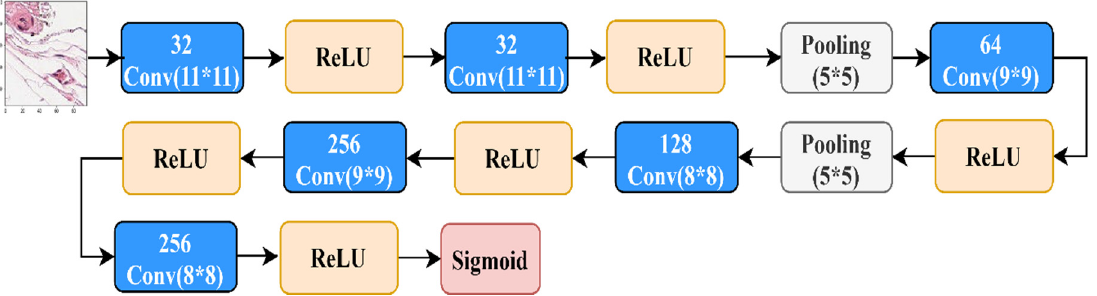
Figure 5. The architecture of Lai et al. [24]. Figure 4. The architecture of Lai et al.